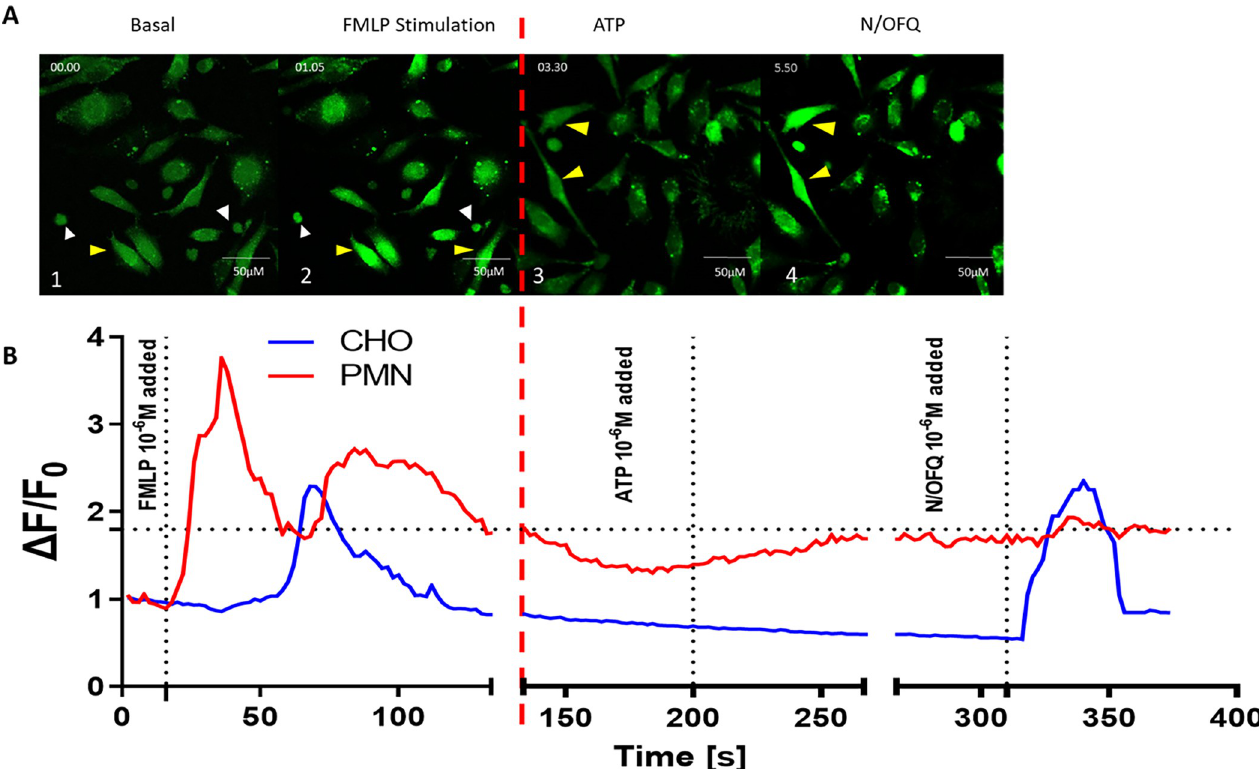
Fig 5. CHO hNOPG α qi5 response to PMN degranulation stimulated by fMLP 1 x10 -6 M in the presence of PPADS (8 x 10 − 4 M) and oATP (5 x 10 -3 M). A. Representative micrograph (from n = 6) depicting 1) basal activity, 2) fMLP stimulation of PMN and subsequent activation of CHO hNOPgq/i5 (with representative samples of labelled CHO (yellow) and PMN (white)), 3) addition of 1x10 -6 ATP as a purinergic challenge and, finally, 4) N/OFQ to demonstrate functional viability of the CHO cells. B. Associated graph demonstrating change in Δ F/F 0 following treatment with fMLP, ATP and N/OFQ. Dotted red line indicates a change of field on the same coverslip to avoid photobleaching due to the length of the experiments.